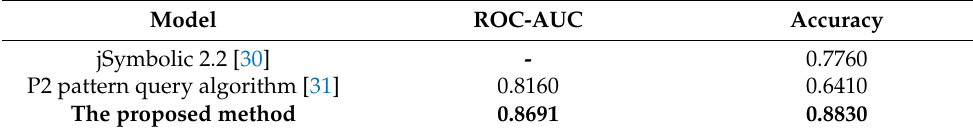
Table 7. Comparison between the proposed method and existing research.